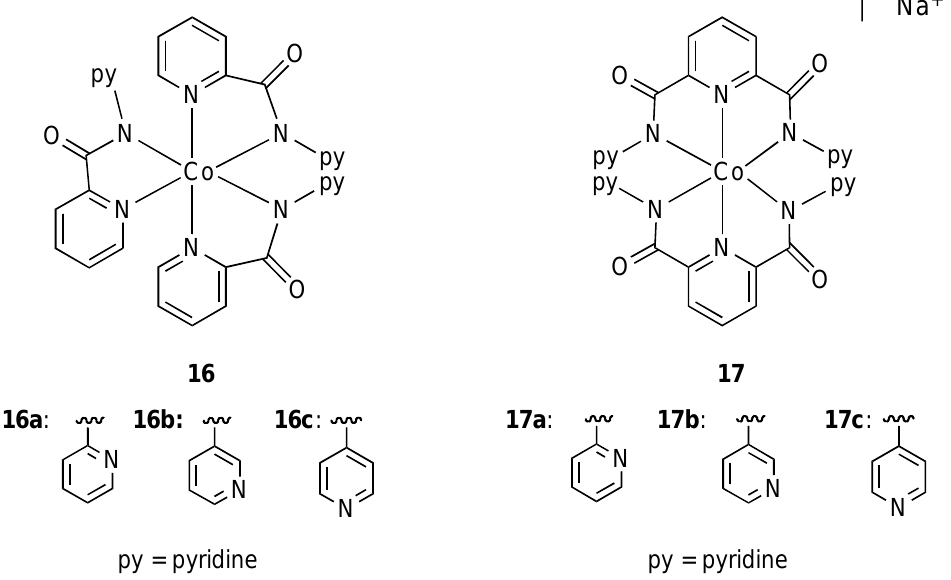
Figure 10. Neutral and anionic pyridine-amide cobalt(III)